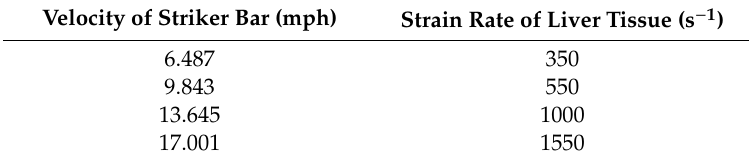
Table 4. Correlation between striker bar speed and resultant strain rate of porcine liver tissue in high-rate